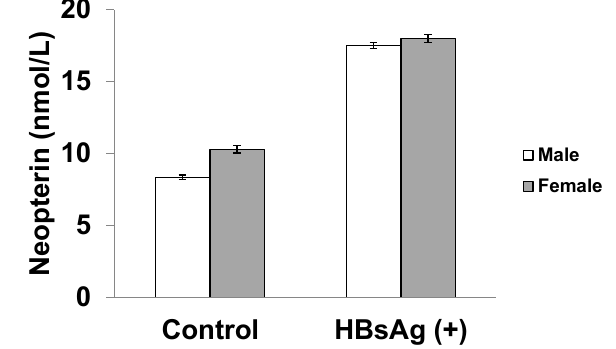
Figure 2: The comparison of neopterin levels (mean +/- SEM) according to the gender.